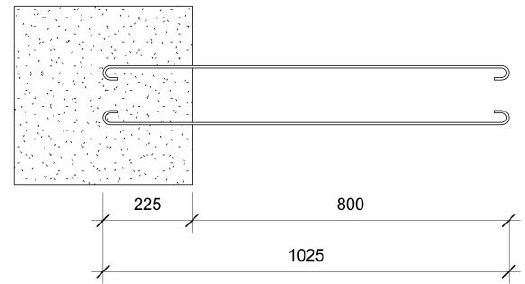
Figure 5. Modeling of masonry tie bars.